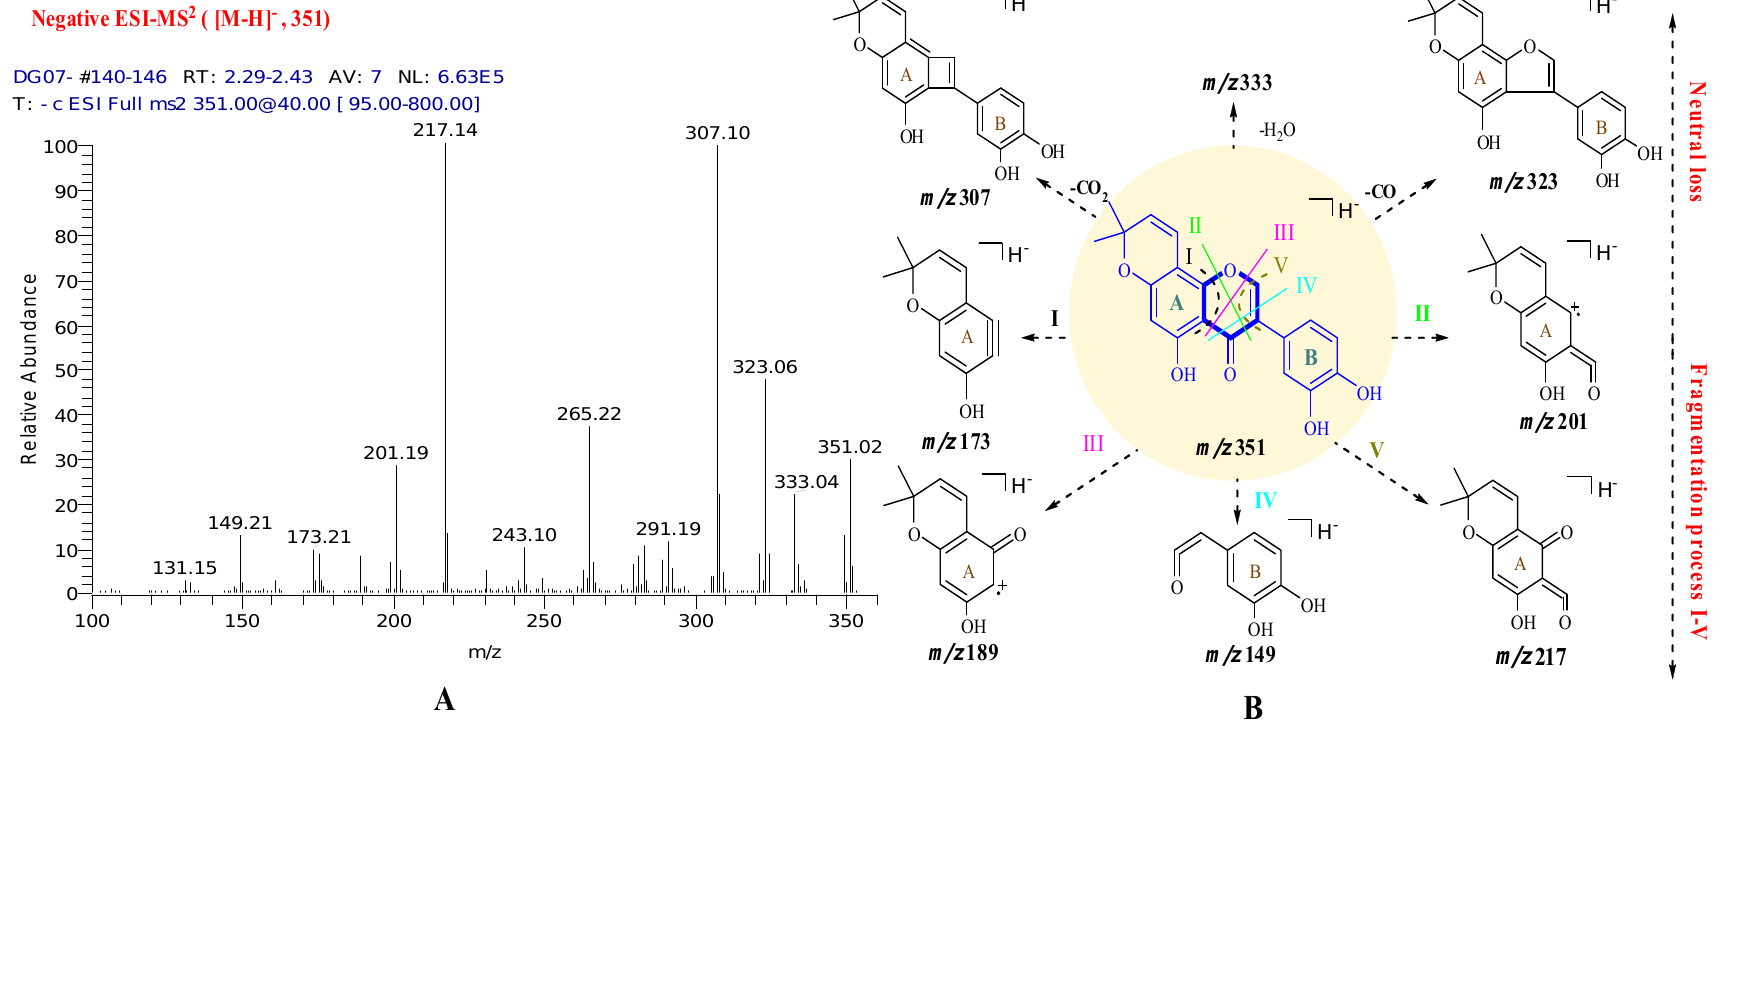
DG07- #140-146 RT: 2.29-2.43 AV: 7 NL: